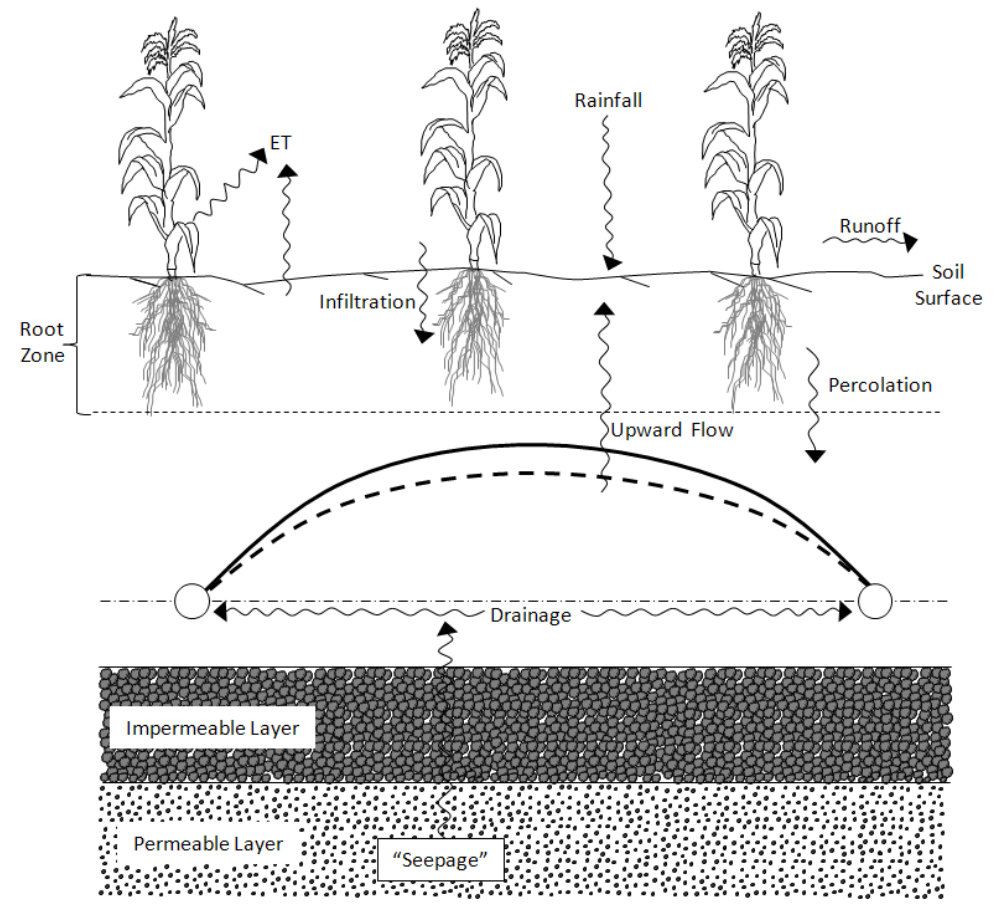
Figure 2. Scheme of the main flow components considered by the model [64].